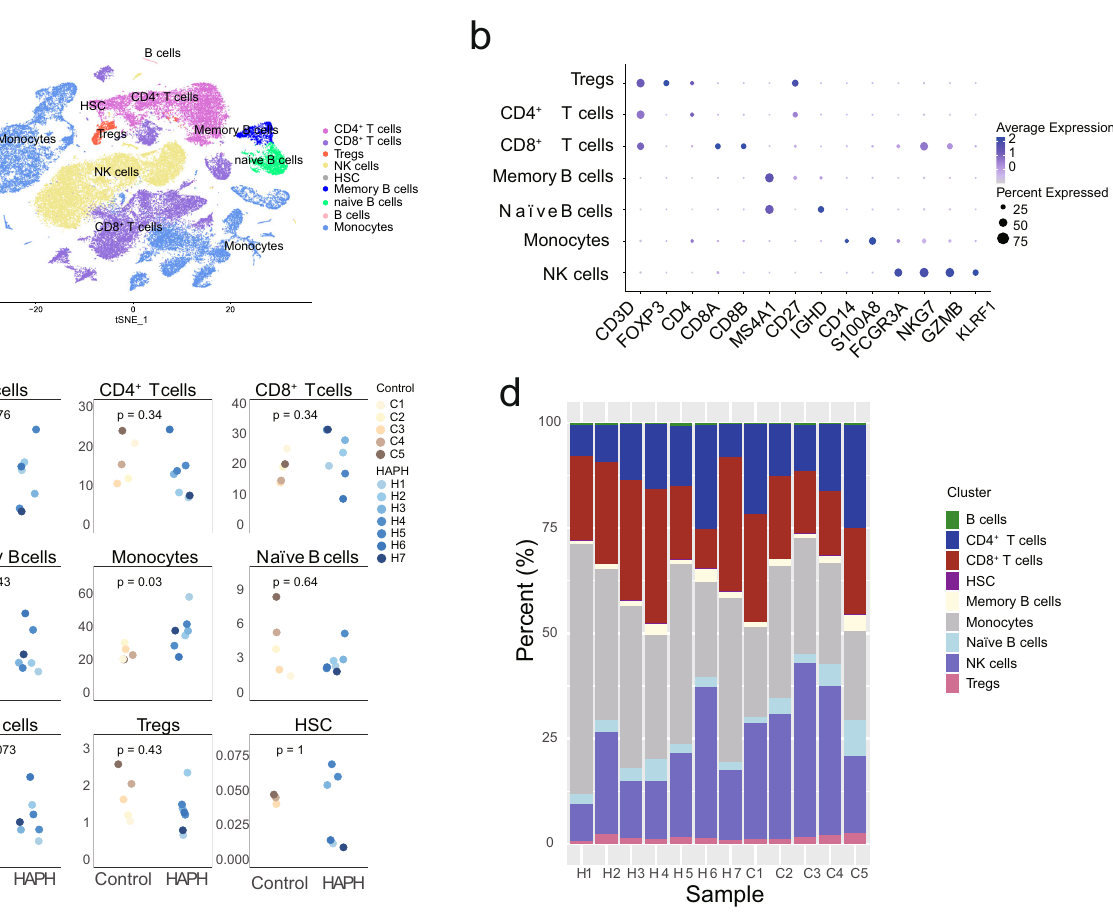
Fig.2|Differentialimmunecellcompositioninthecirculationofpatientswith HAPH. a t-SNE plot of the main immune cell subsets. b Dot plot depicting the percentages and average expressions of the canonical genes associated with each main immune cell cluster. c Boxplots comparing the percentages of indicated cell typesinPBMCsbetweenHAPHpatients( n =7)andcontrolparticipants( n =5).The